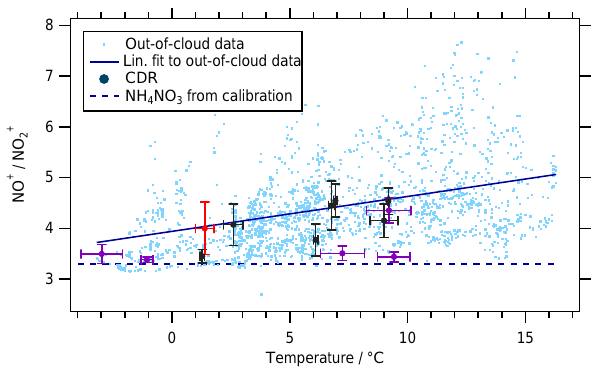
Figure 11. Ratio of NO + ( m/z 30) to NO + ( m/z 46) measured 2 using the C-ToF-AMS as a function of temperature. Out-of-cloud data represent 15min averages; CDR data are averaged over the full cloud events; error bars denote standard deviation. The solid line is a linear fit to the out-of-cloud data; the dashed line shows the ratio obtained during calibration with pure NH 4 NO 3 . The CDR data are color coded as follows: black: nighttime cloud events; purple: day and night; red: daytime